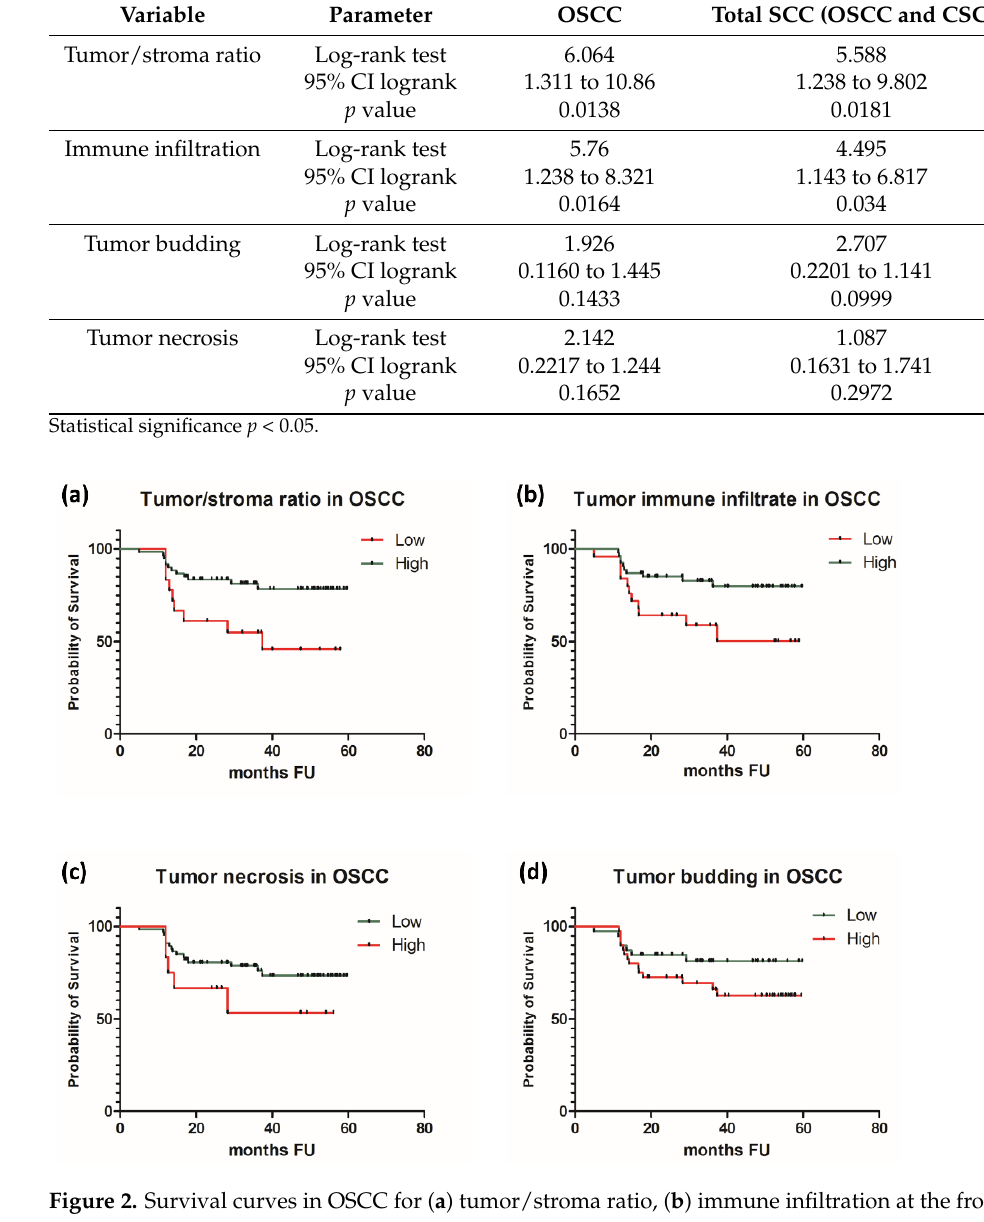
Table 5. Survival analysis.